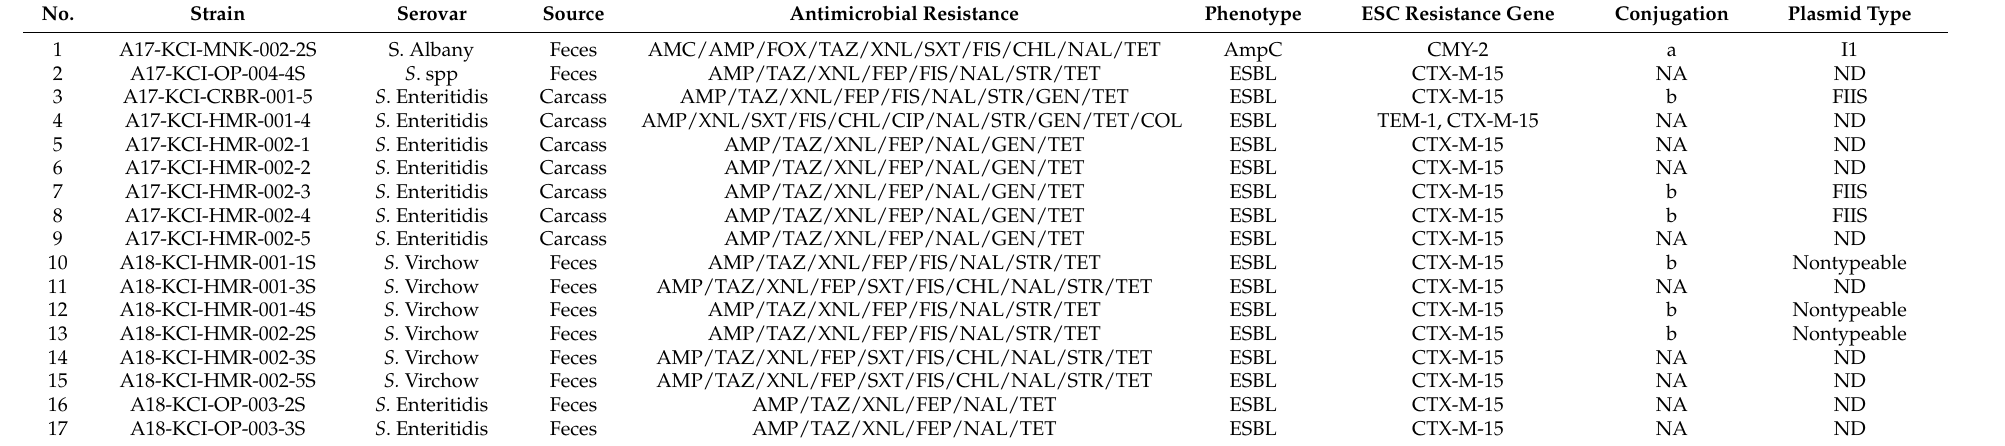
Table 1. Information on 17 cephalosporin-resistant Salmonella spp. isolated from chicken-related sources.